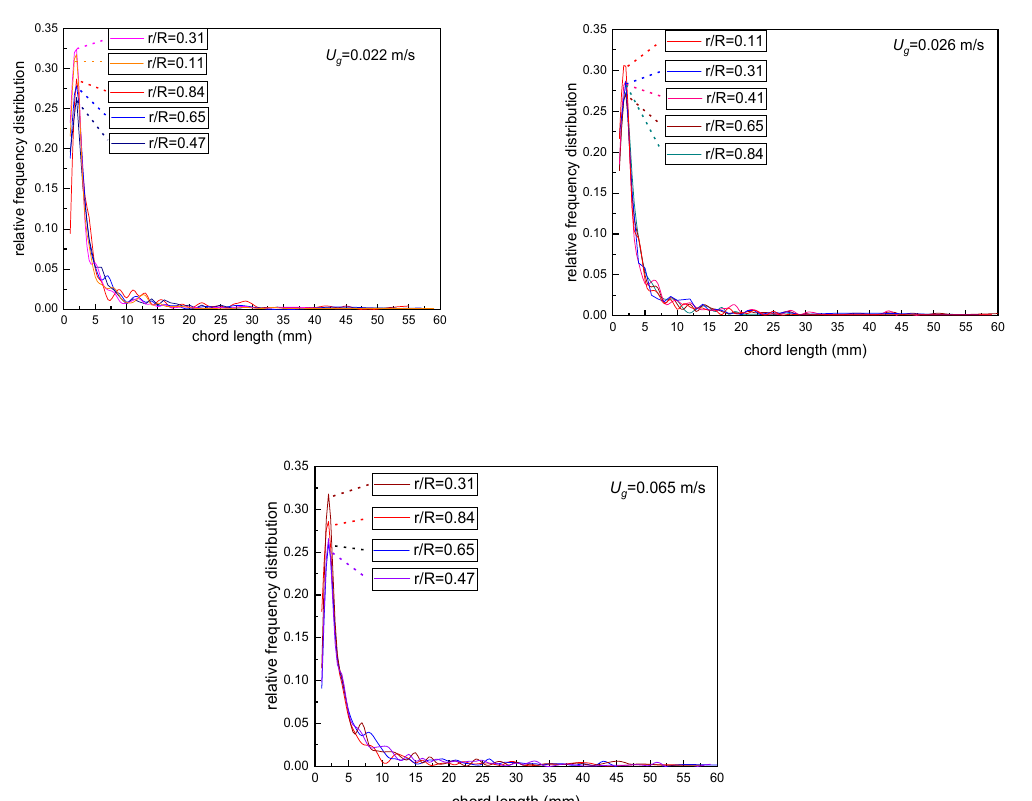
Figure 9. The relative frequency distribution of chord length as a function of radial position at different superficial gas velocities.